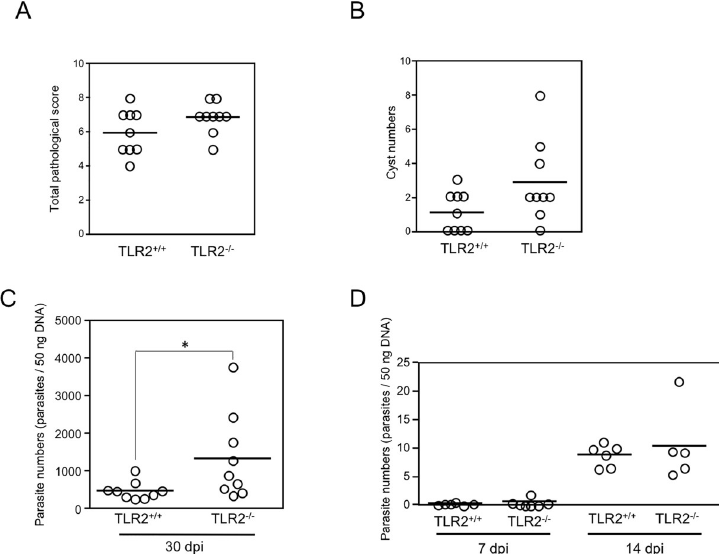
Fig 4. Histopathological lesions and parasite burdens in the brains of T . gondii -infected mice. On day 30 after infection, brain samples were collected. The total pathological score (A) and number of brain cysts (B) were calculated. Each circle represents the data for one mouse, and the bars represent the average values for all the data points in two independent experiments (TLR2 +/+ mice, n = 9; TLR2 –/– mice, n = 9). There was no statistically significant difference between the two groups in the unpaired t test ( � p = 0.0628). (C) On day 30 after infection, brain samples were collected. DNA was extracted from each brain sample and the parasite numbers were quantified. Each circle represents the data for one mouse, and the bars represent the median value from all the data points in two independent experiments (TLR2 +/+ mice, n = 9; TLR2 –/– mice, n = 9). Statistically significant differences were determined by the Mann-Whitney test ( � p = 0.0315). (D) TLR2 +/+ mice and TLR2 –/– mice were infected with T . gondii tachyzoites. On day 7 and 14 after infection, brain samples from all the mice were collected. DNA was extracted from each sample and the parasite numbers were quantified. Each circle represents the data for one mouse, and the bars represent the average values for all the data points in one experiment (TLR2 +/+ mice, n = 6; TLR2 –/– mice, n = 5). Significant differences were determined by unpaired t tests ( � p <